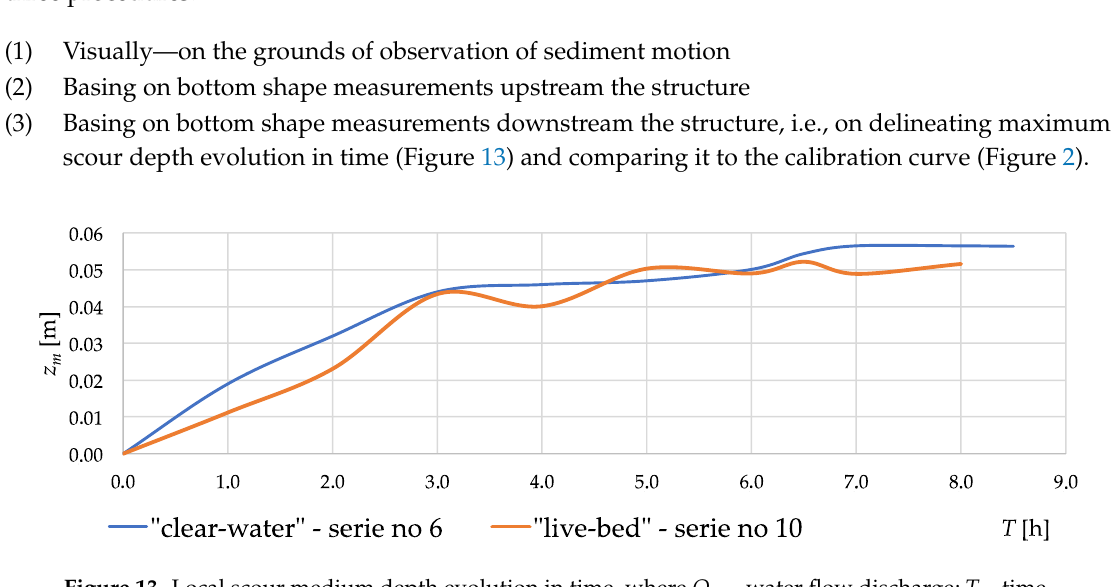
Figure 13. Local scour medium depth evolution in time, where Q w —water flow discharge; T —time. Also, scour length evolution was observed and investigated (Figure